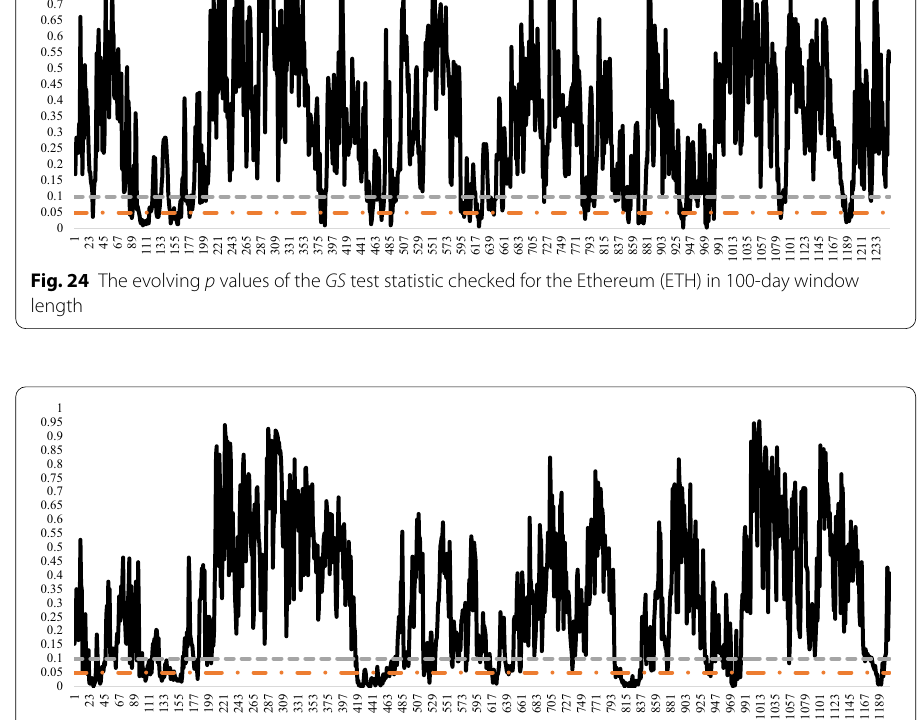
Fig. 25 The evolving p values of the GS test statistic checked for the Ethereum (ETH) in 150-day window